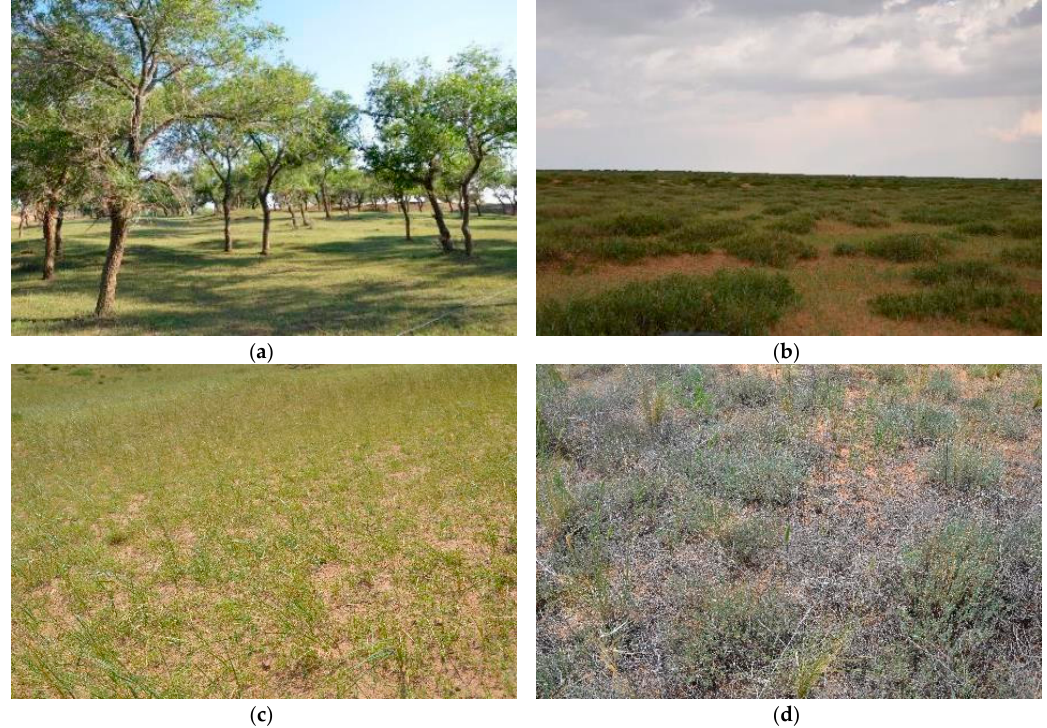
Figure 2. Photos of major vegetation structure and characteristics in the Otindag Sandy Land: ( a ) open woodland; ( b ) grassland encroached by shrub; ( c ) degraded grassland; and ( d ) high percentage of non-photosynthetic vegetation (NPV).